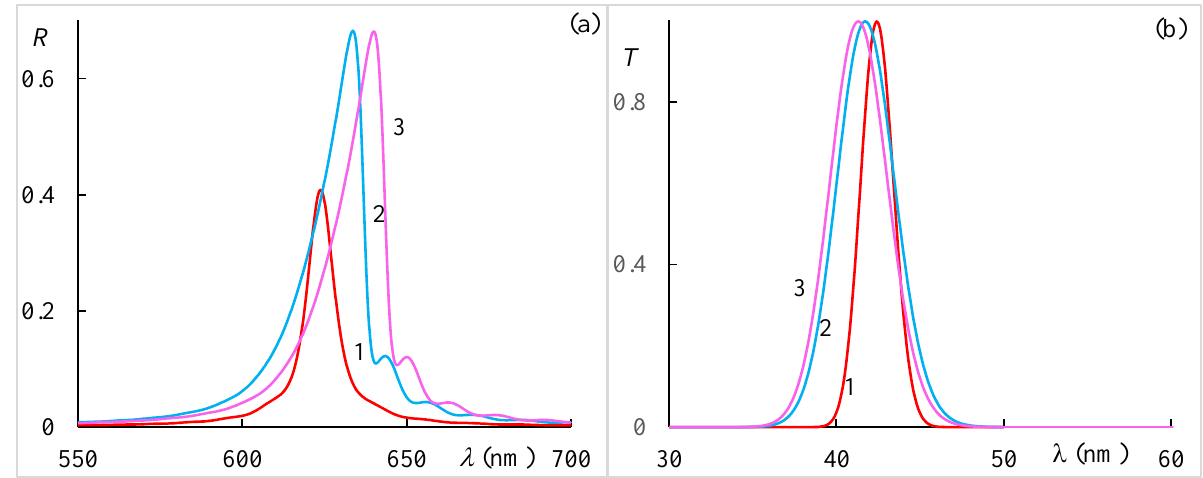
Figure 13. ( a ) The spectra of reflection near the PBG and ( b ) the spectra of transmission near the magnetically induced transparency.